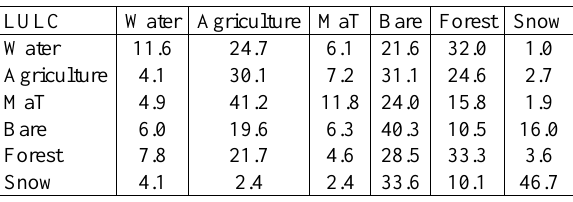
Table 1. Changes in LULC in percentage (%), specifying each type of